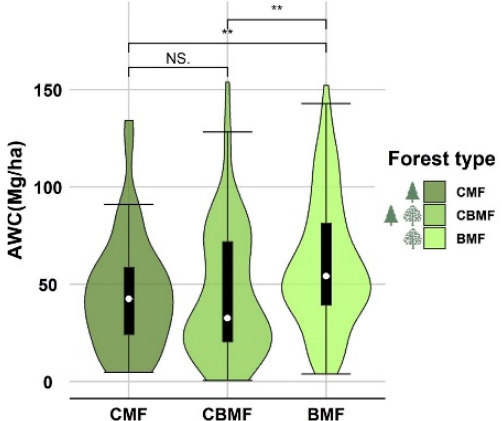
Figure 3. Kernel density estimation of aboveground wood carbon (AWC) in three different kinds of mixed forests. CMF, CBMF, and BMF represent coniferous mixed forests, coniferous–broadleaf mixed forests, and broadleaf mixed forests, respectively. The white points represent the mean values and the height and width of the graph represent the range and frequency of the distribution, respectively. The white points represent the mean values and the black lines represent the standard deviations. One-way analysis of variance (ANOVA) followed by the LSD test was used to analyze the differences of AWC among in three different kinds of mixed forests. The symbols ** denote significant differences in the different forest types at P < 0.01. NS represents no significance in the different forest types at P > 0.05.